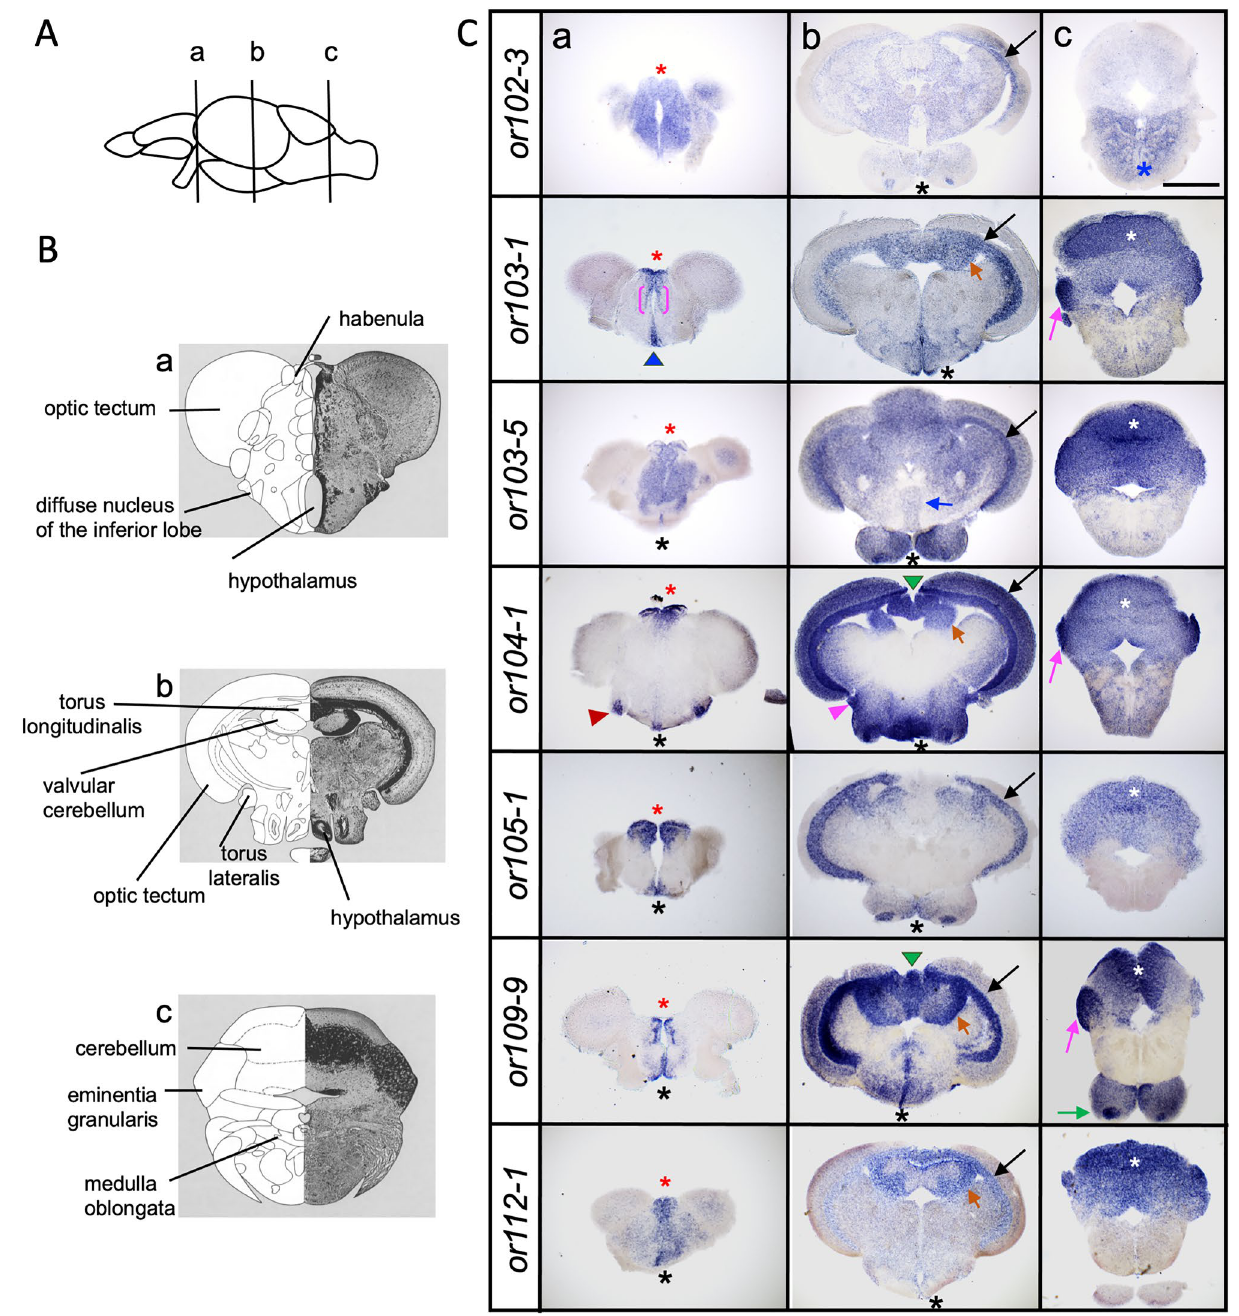
Figure 5. Olfactory receptor genes are expressed in the adult zebrafish brain. ( A ) Schematic drawing of a lateral view of the adult zebrafish brain indicating the anterior–posterior levels (a–c) of the transverse sections in ( B ) and ( C ). ( B ) Schematic image of transverse sections of adult zebrafish brain with different areas labeled in the forebrain (a), midbrain (b) and hindbrain (c) areas. Modified from Wulliman et al. 24 . ( C ) Representative transverse sections of adult zebrafish brains processed by in-situ hybridization for or102-3 , or103-1 , or103-5 , or104-1 , or105-1 , or109-9 and or112-1 show different patterns of expression in distinct brain regions. Olfactory receptor gene transcripts are found in the habenula (red asterisk), preoptic area (blue arrowhead), hypothalamus (black asterisk), ventral thalamus (magenta bracket), diffuse nucleus of the inferior lobe (red arrowhead), optic tectum (black arrow), torus longitudinalis (green arrowhead), valvular cerebellum (orange arrow), eminentia granularis (magenta arrow), interpeduncular nucleus (blue arrow) cerebellum (white asterisk), medulla oblongata (blue asterisk), torus lateralis (magenta arrowhead). Scale bar = 500